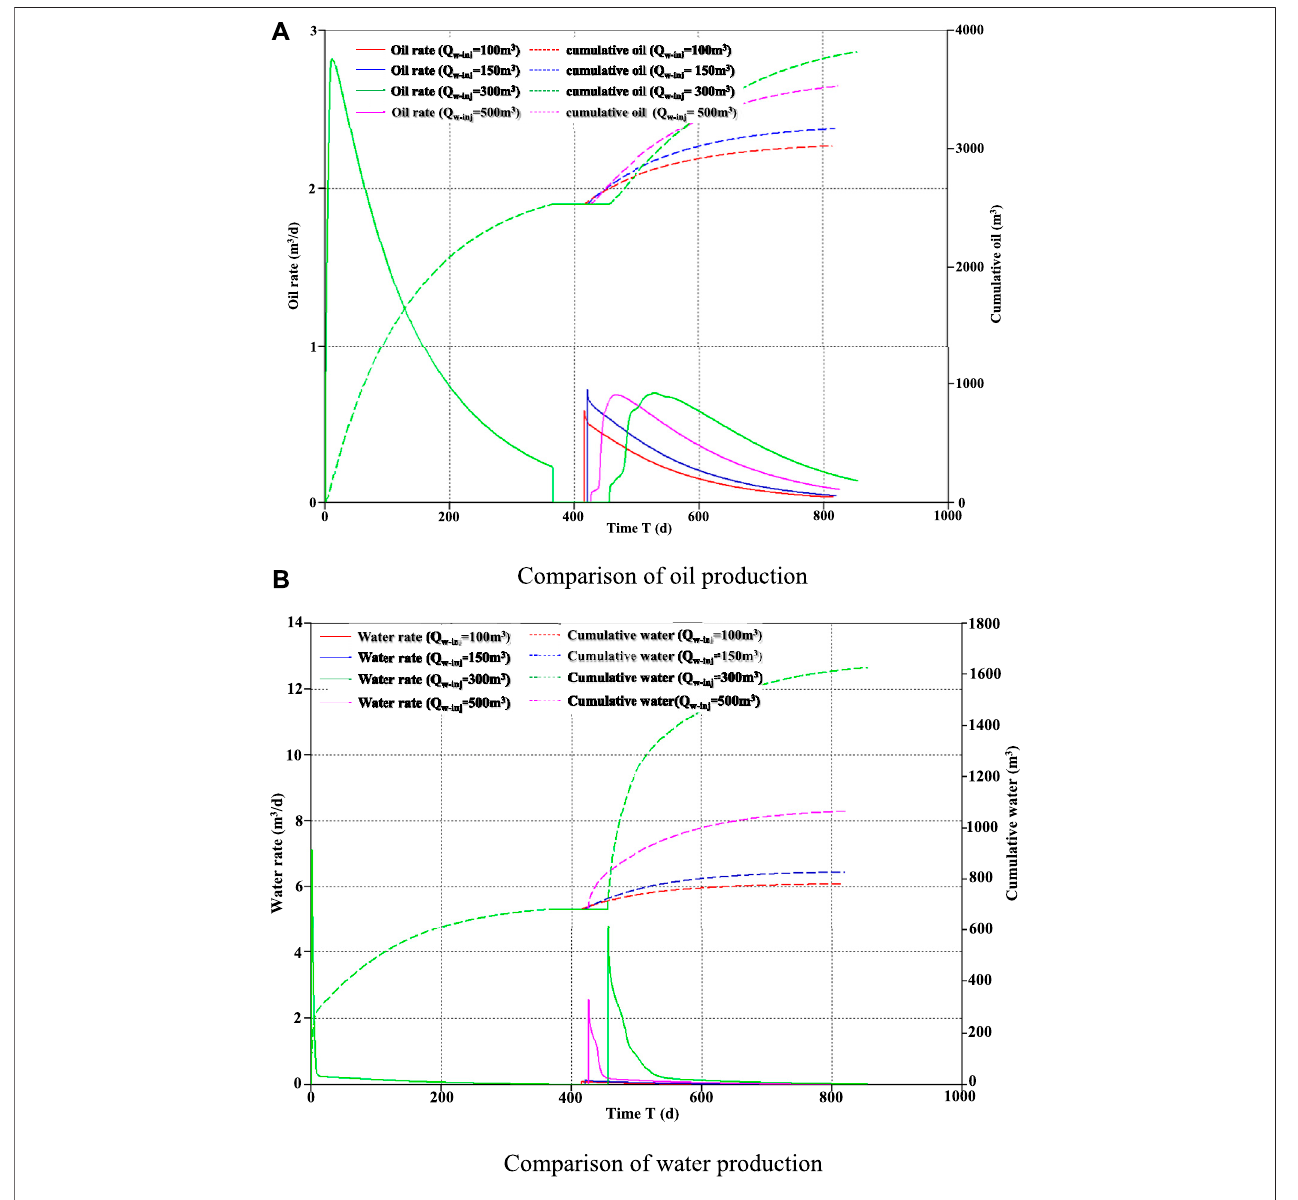
FIGURE 11 | Comparison of oil and water production with different injection volumes. (A) Comparison of oil production. (B) Comparison of water production.